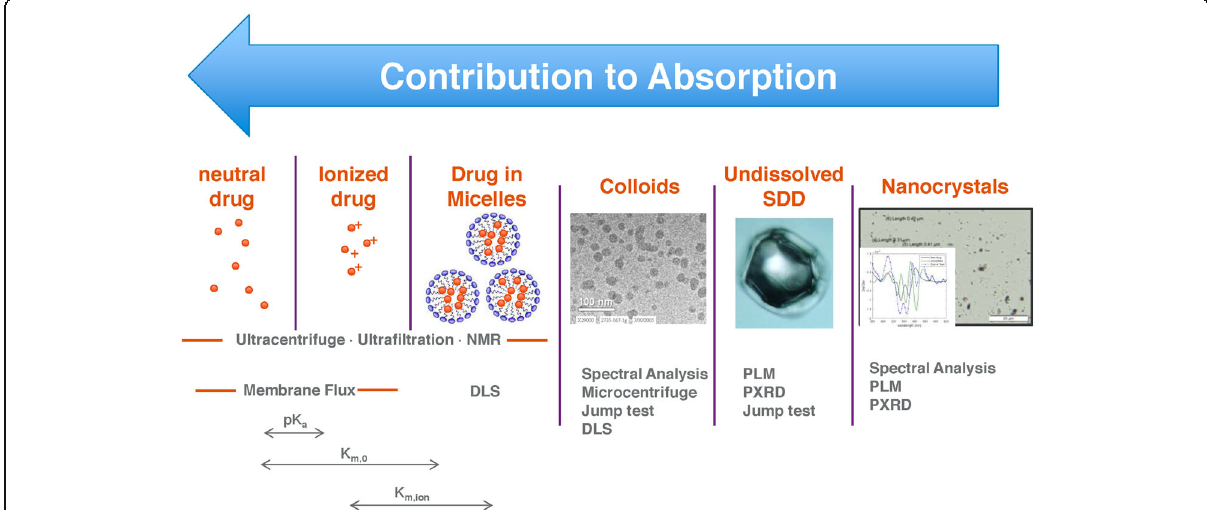
Fig. 9 Speciation of dissolved and suspended drug species (reproduced with permission from Capsugel)